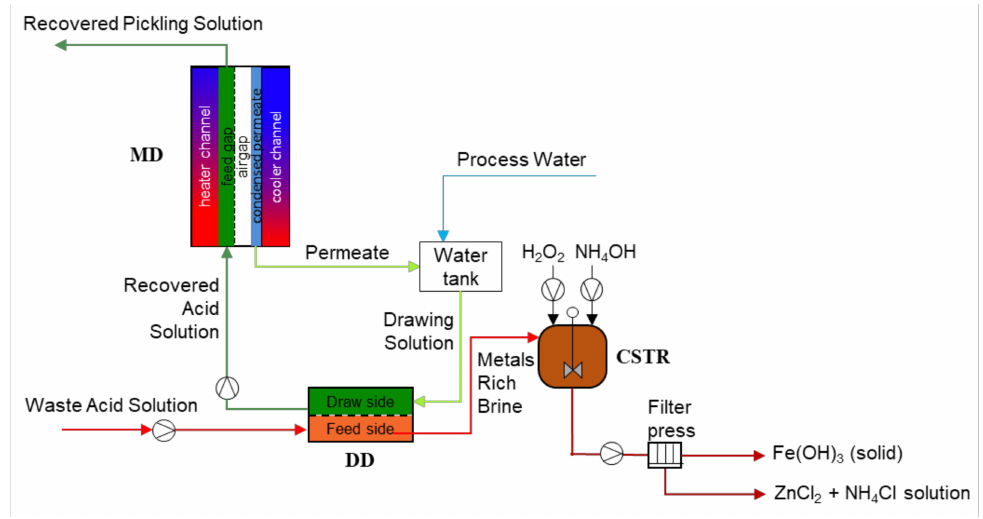
Figure 1. Schematic representation of the integrated hybrid membrane